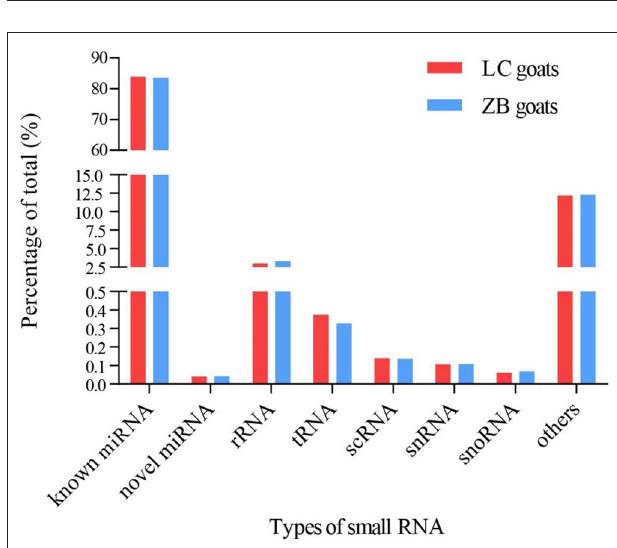
FIGURE 2 | The percentage of small RNA types in Longissimus dorsi muscle of Liaoning cashmere (LC) and Ziwuling black (ZB) goats. Known miRNAs included mature caprine miRNAs and species-conserved miRNAs. Others RNAs included the sequences aligned to exon and intron, repeated sequences, caprine miRNA edit, and sequences that were not aligned to any